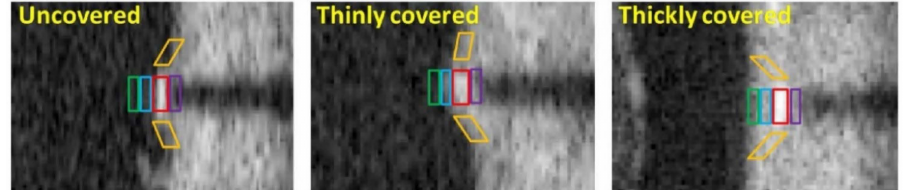
Figure 11. Patches used to extract features for uncovered, thinly covered, and thickly covered struts. Side patches (orange) capture continuity of the tissue, while the green, blue, red, and purple patches highlight the front, middle, stent strut and backside pixel regions, respectively. Reprinted from [182], with permission, under the Creative